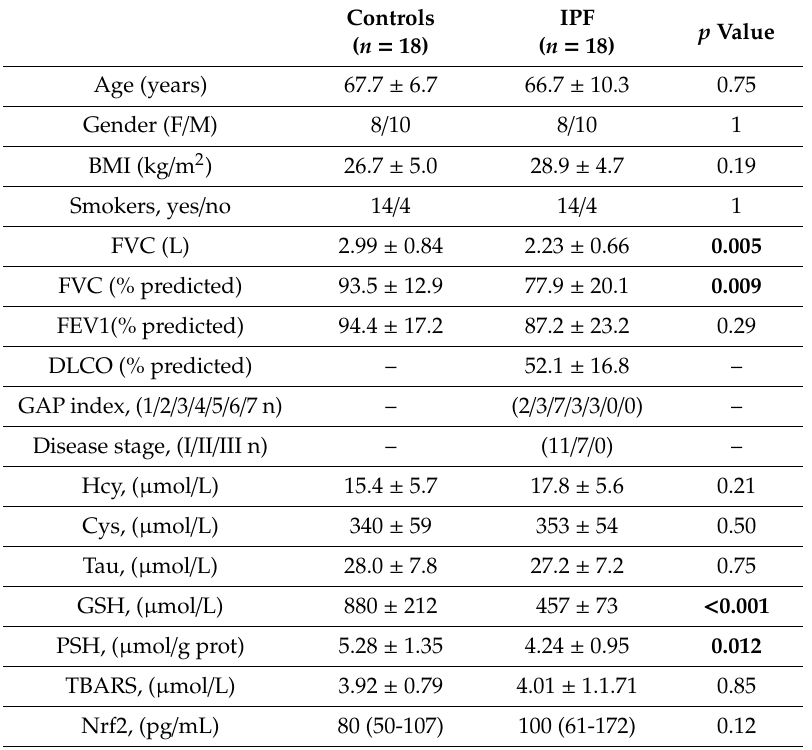
Table 1. Demographic, clinical and biochemical characteristics of healthy subjects and IPF